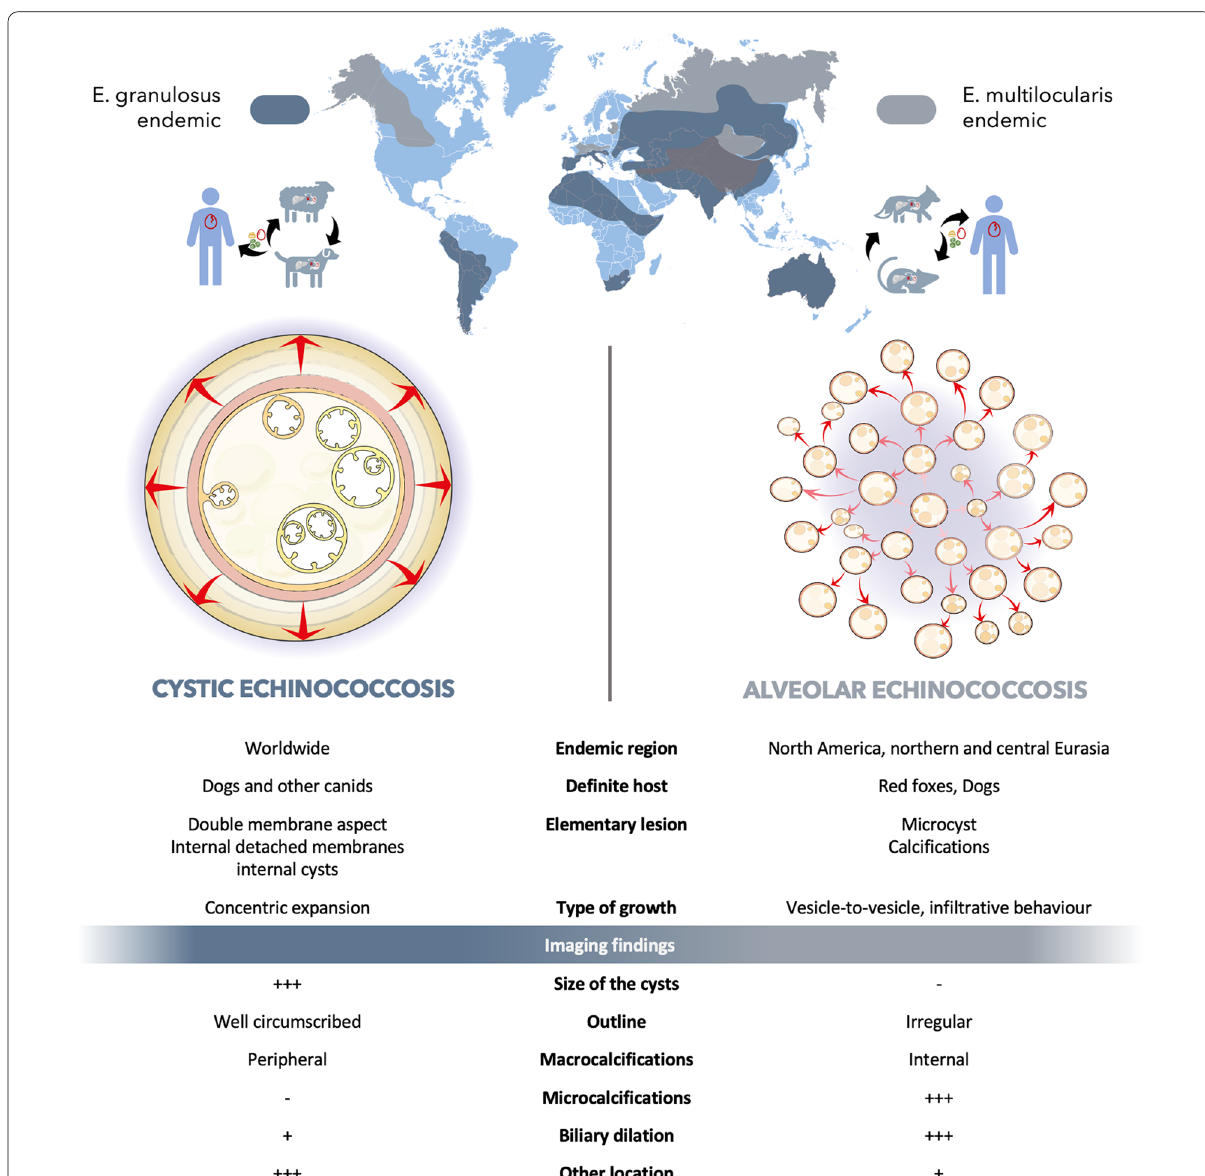
Fig. 1 Figure representing type of growth, main demographic and imaging findings of cystic (CE) and alveolar echinococcosis